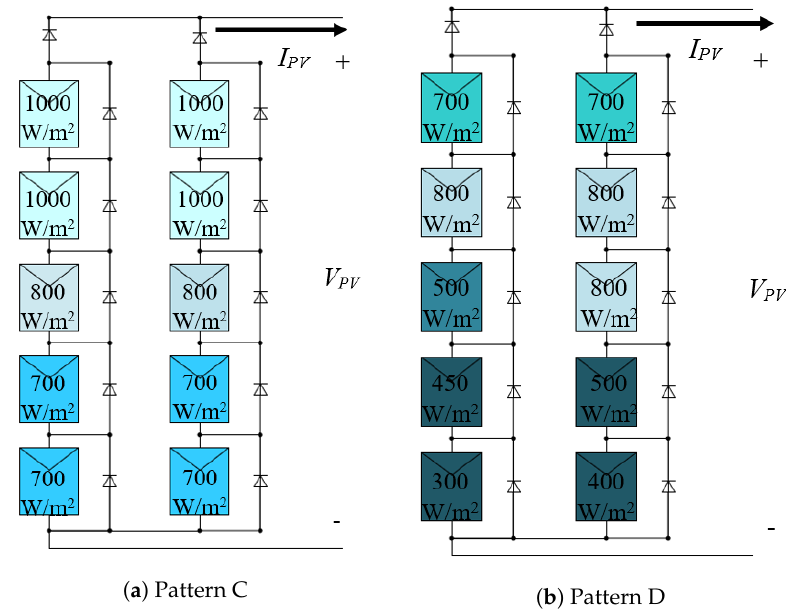
Figure 7. ( a ) Pattern C at 25 ◦ C, ( b ) pattern D at 30 ◦ C. Table 2. Parameters for Single PV